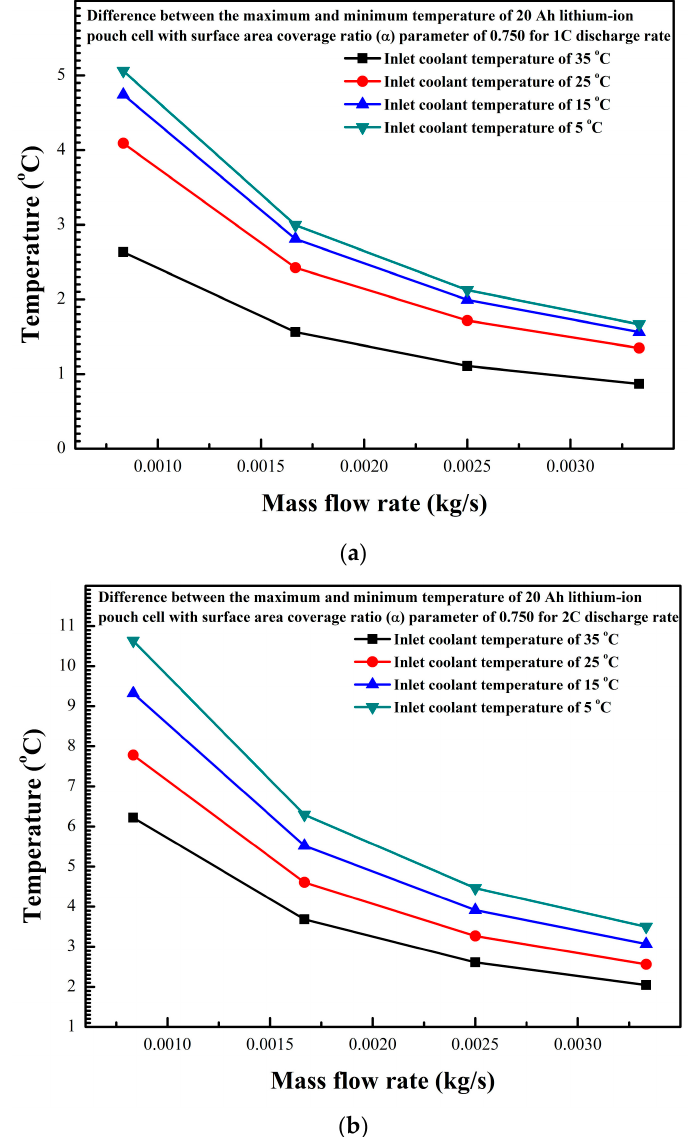
Figure 6. Difference between the maximum and minimum temperature of the 20 Ah lithium-ion pouch cell with surface area coverage ratio ( α ) parameter of 0.750: ( a ) 1C; ( b ) 2C.